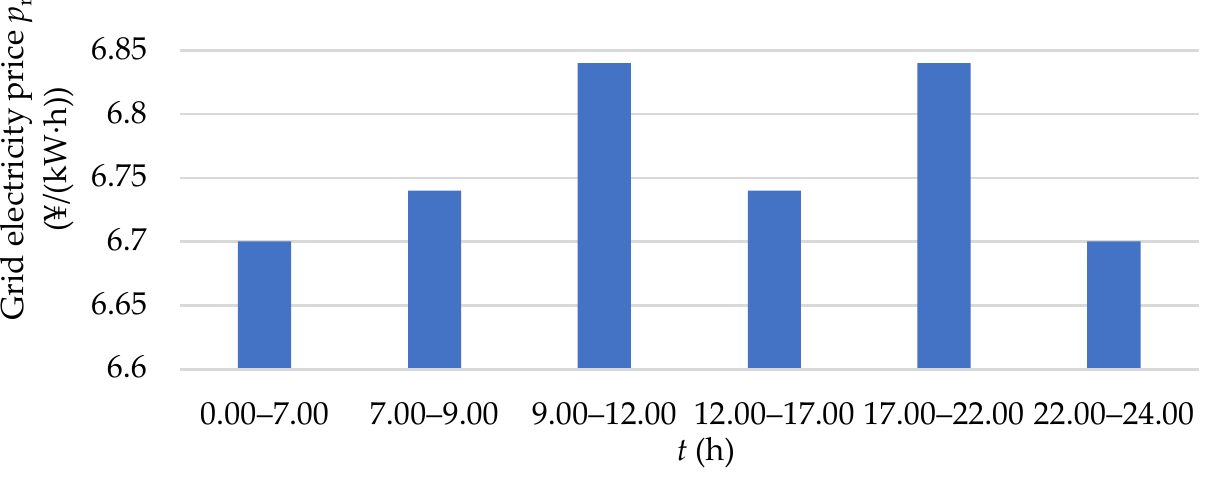
Figure 11. TOUP of the whole